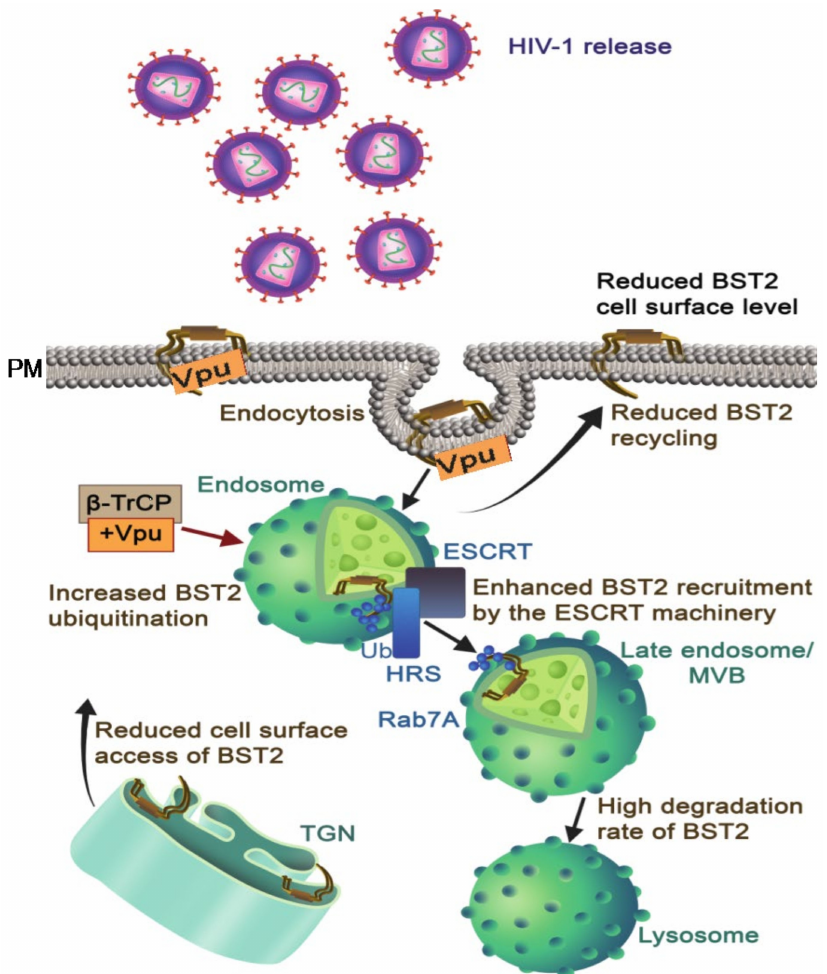
Figure 3. BST-2 surface downregulation and degradation by Vpu: In the absence of Vpu, BST-2 restricts newly synthesized viruses at the cell membrane, but Vpu downregulates BST-2 from the cell surface and promotes the release of virus particles from HIV-1-infected cells and enhances ubiquitination and lysosomal degradation of BST-2 by recruiting β -TrCP and exploiting the ESCRT pathway (ESCRT, HRS, and Rab7A). Besides, Vpu restricts BST-2 trafficking to the cell membrane from TGN and endosomes to reduce BST-2 level on the cell surface (indicates by arrows).